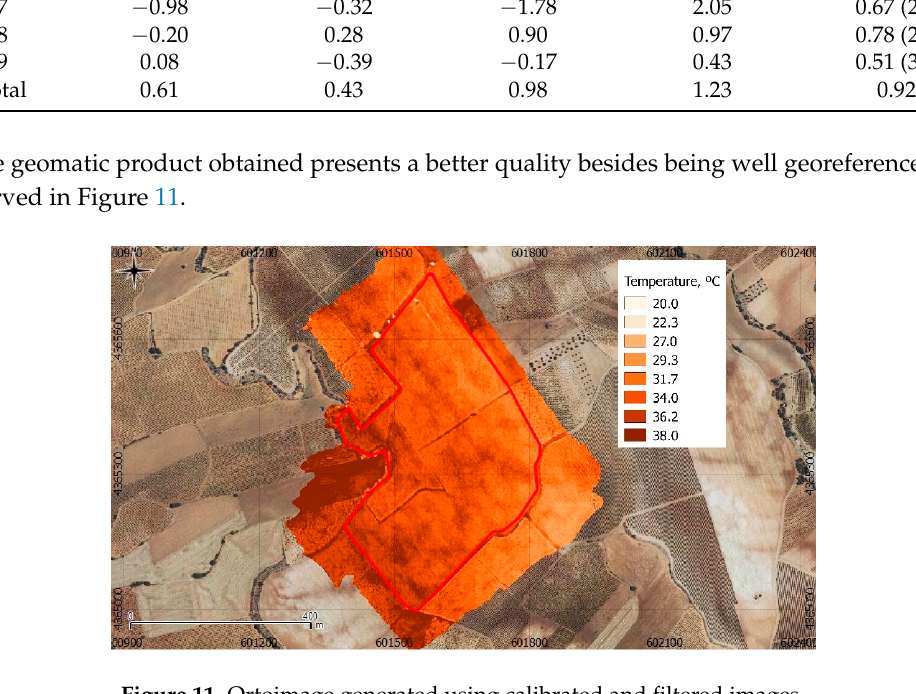
Table 5. Control points of the filtered and calibrated geometrically images.